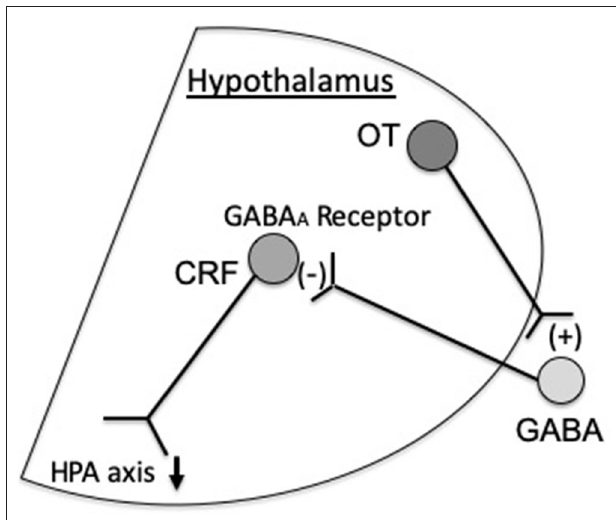
FIGURE 1 | Oxytocin (OT) inhibits corticotropin-releasing factor (CRF) expression via GABA A receptors at the paraventricular nucleus (PVN), which inactivates the hypothalamic–pituitary–adrenal (HPA) axis. In addition, others suggested that hypothalamic OT stimulates the production of alpha 2-adrenoreceptors in the nucleus tractus solitarius (NTS) and locus coeruleus (LC) on noradrenergic neurons projecting to the CRF neurons, which suppress CRF expression (Uvnäs-Moberg et al.,